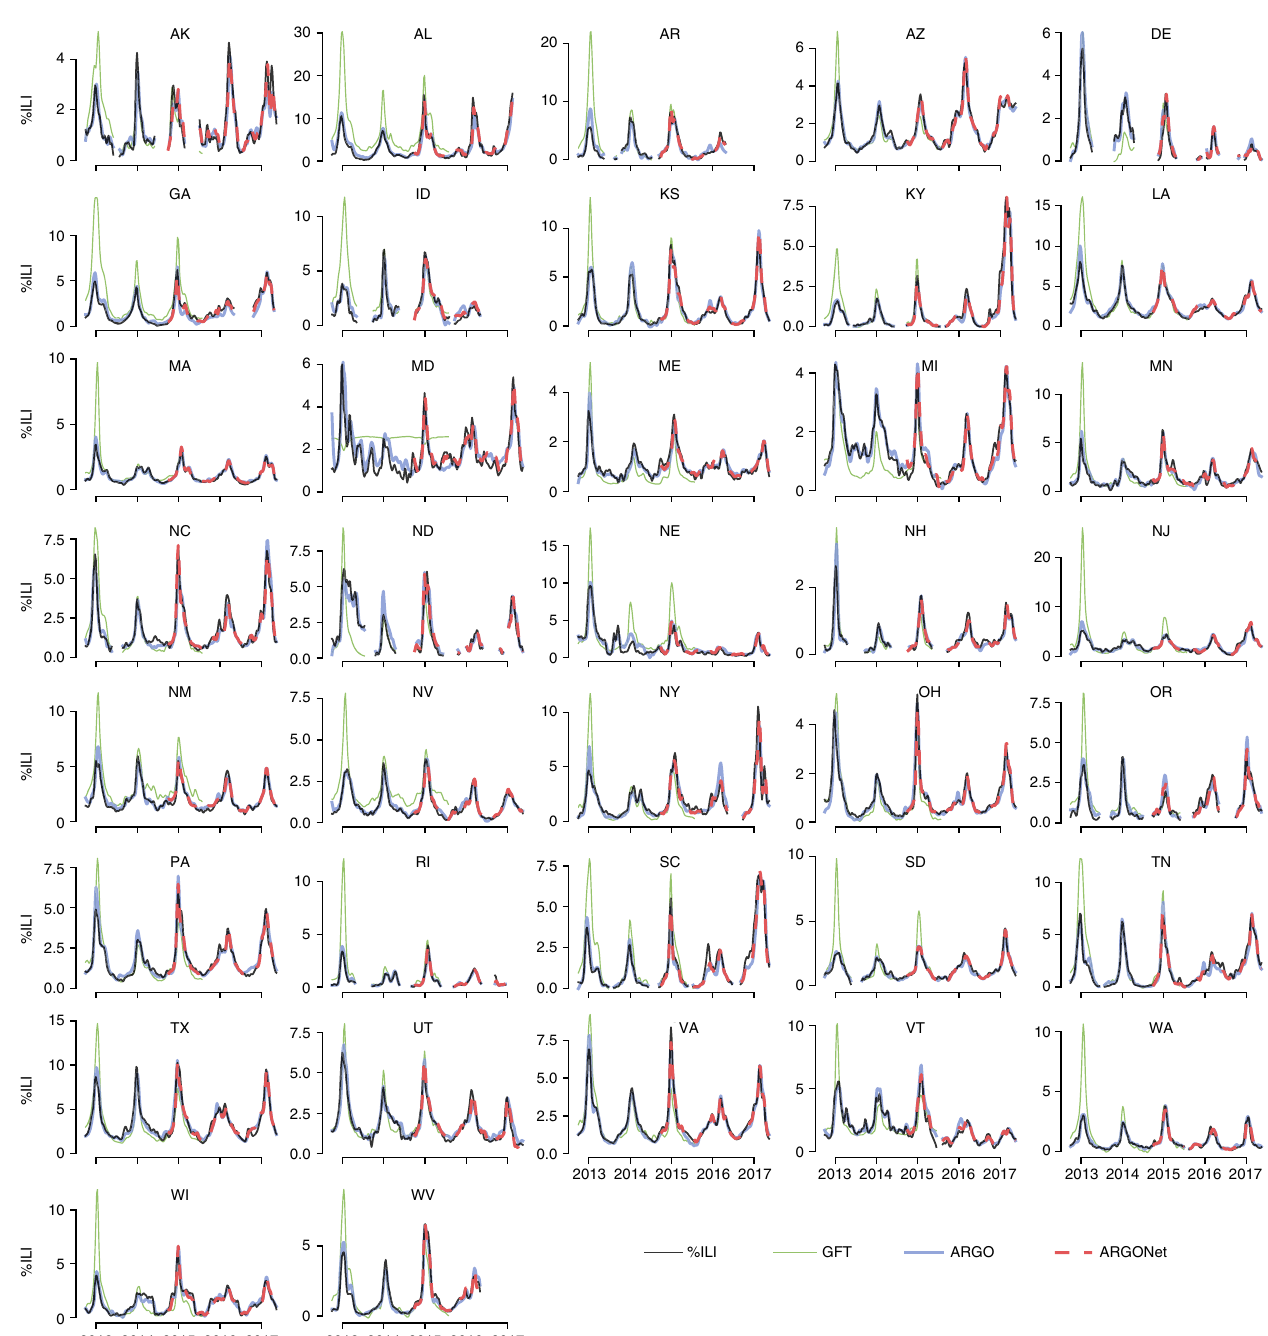
Fig. 4 Time series plots displaying the performance of ARGO and ARGONet relative to the of fi cial CDC %ILI time series. Results are shown over the entire out-of-sample prediction period (September 30, 2012 to May 14, 2017). The GFT benchmark is also shown. Refer to Supplementary Figure 1 for